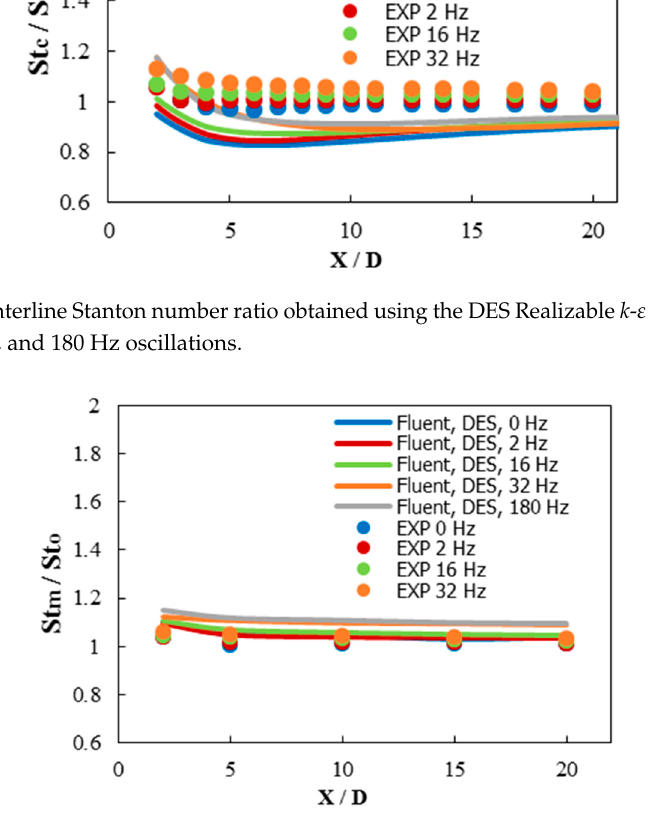
Figure 20. The centerline effectiveness obtained using the LES Smagorinsky–Lilly model for M = 0.5 for the 180 and 268 Hz oscillations [28].